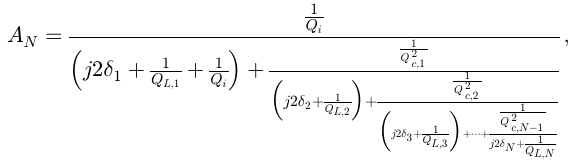
Fig. 6. The A , R , and T spectra and the electrical ¯eld distributions: (a) spectra for structure EG(BC) 2 with single Fano-like absorption peak; (b) spectra for structure EG(BC) 6 with ¯ve Fano-like absorption peaks; (c) and (d) the electrical ¯eld distributions corresponding to the absorption peaks in (a) with Lorentzian and Fano-like shapes. Each layer of EG(BC) 2 is marked with di®erent colors from the left to the right. Structure parameters include n prism ¼ n b ¼ 3 : 48, d b ¼ 120 nm, n c ¼ 1 : 55, d c ¼ 269 nm, n e ¼ 1 : 23, and d e ¼ 100 cavity; (cid:5) ( z ¼ 1, . . . , N (cid:3) 1) are those between the z ¼ 2 (cid:4) (cid:2) f is the adjacent cavities, respectively; (cid:2) ! q q angular frequency detuning from the resonance